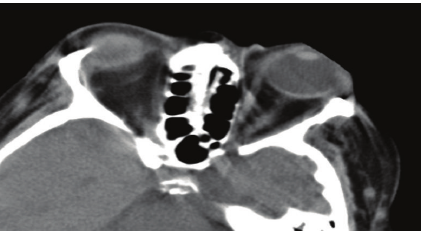
Figure2:CTscanoftheorbitsshowingbilateralpreseptalsofttissue swelling, more on the left side, soft tissue stranding in left intra- and extraconal fat, and left-sided mild